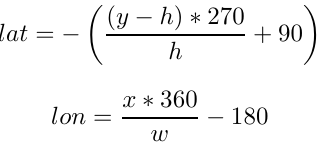
Fig. 11. Cayman Islands were responsible for hosting many websites of child pornography content in